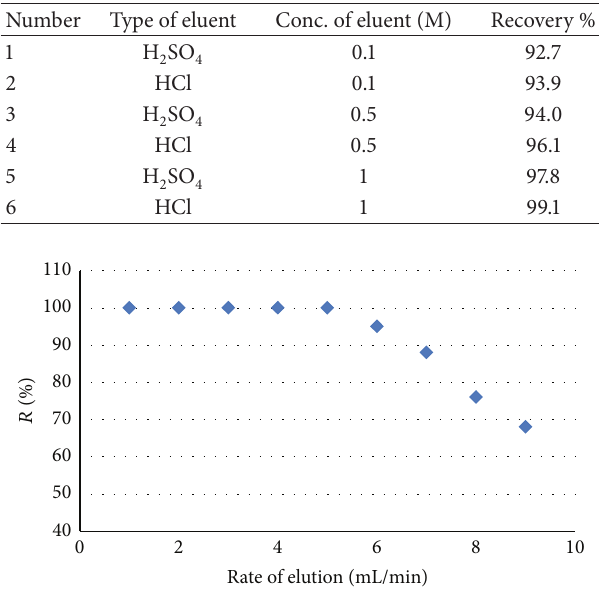
Table 2: The effect of different amounts of eluents on the recovery of arsenic in the preconcentration procedure.